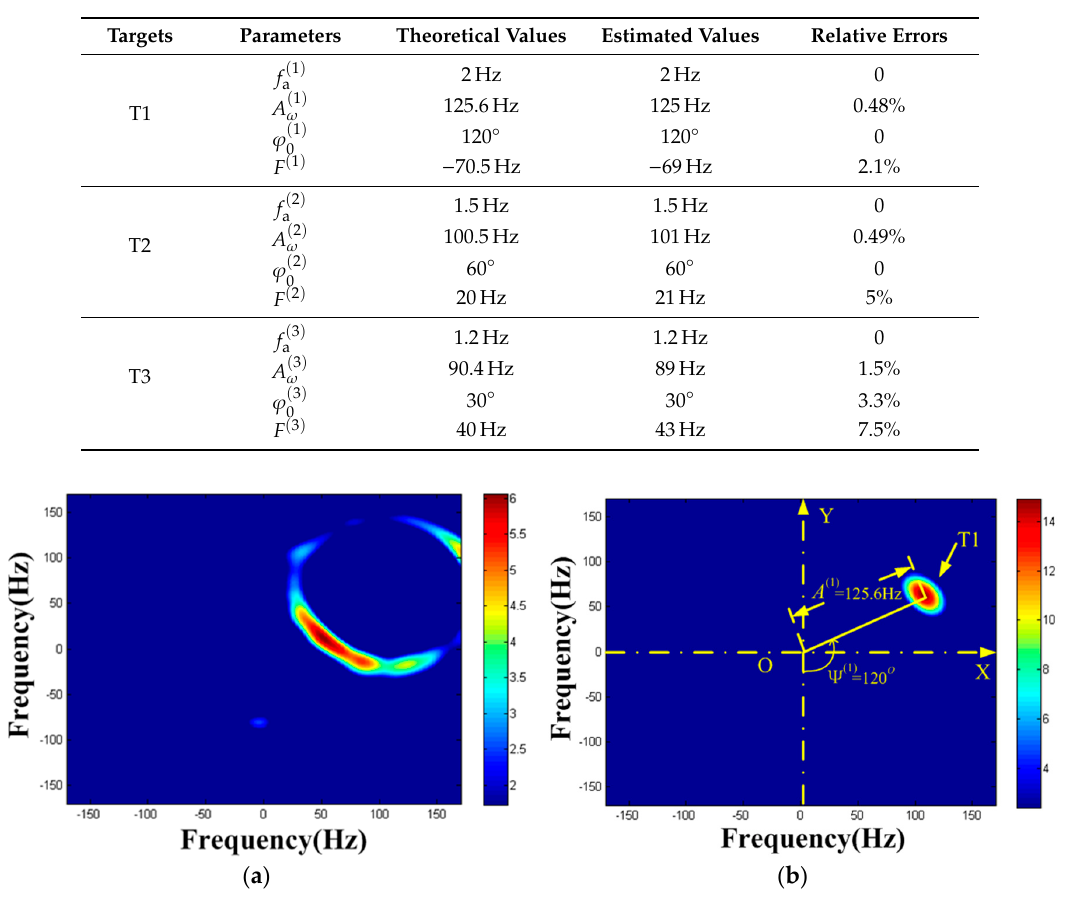
Table 2. Theoretical values and estimated values of the parameters.